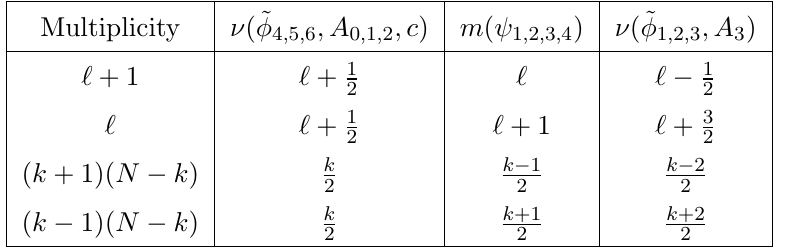
Table 1 . Masses and (cid:23) ’s of the modes propagating only for x 3 > 0, with ‘ = 0 ; : : : ; k (cid:0) 1 [8, 9]. In addition, ( N (cid:0) k ) 2 massless modes exist that propagate on both sides of the